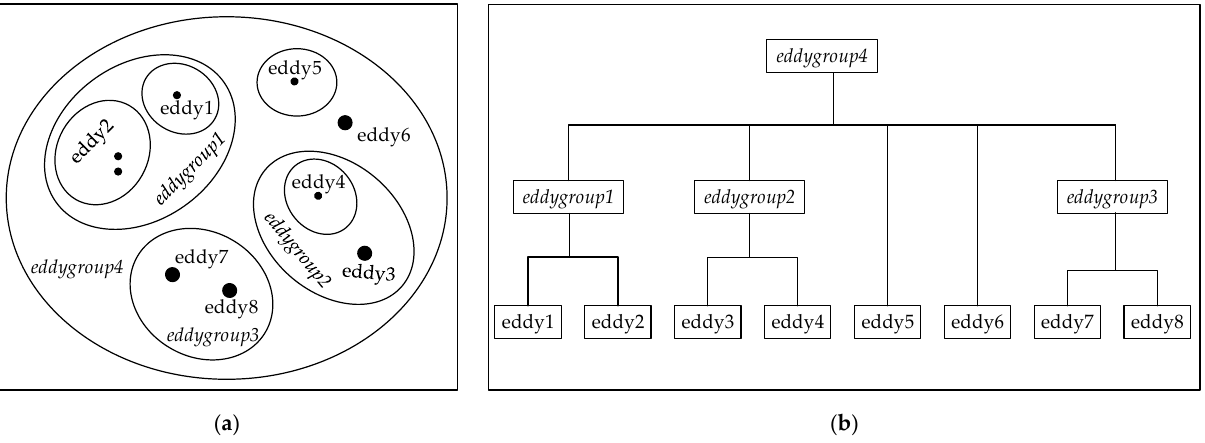
Figure 2. ( a ) A diagram of an eddytree ; ( b ) the structure of the eddytree corresponding to ( a ).